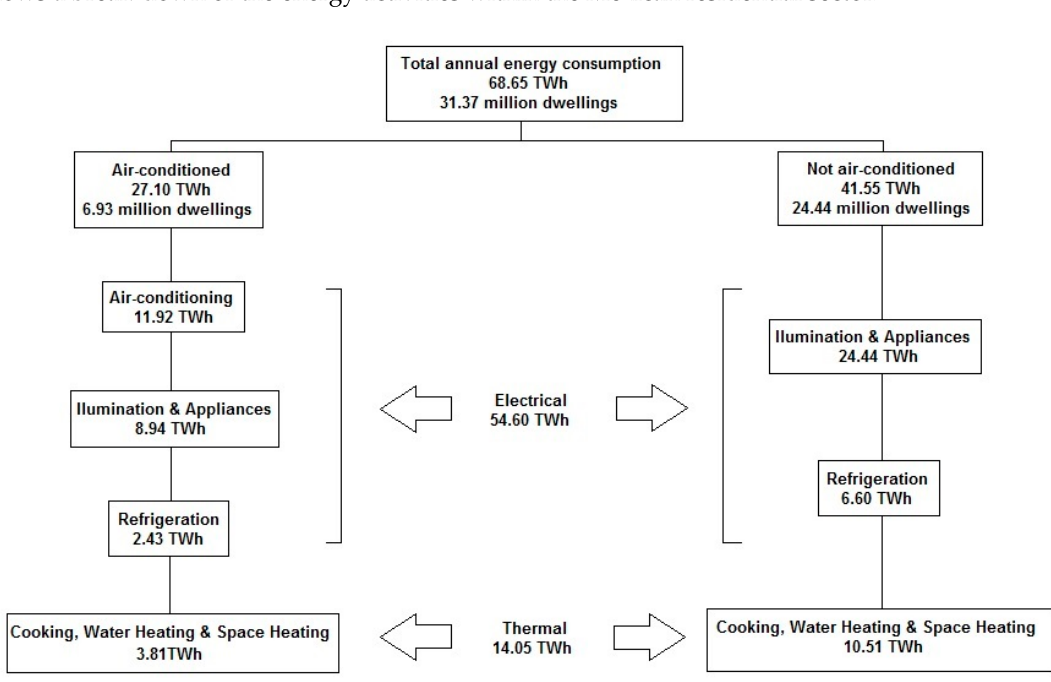
Figure 3. Energy use onto the Mexican residential sector in 2015.